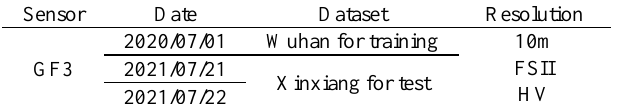
Table 1, the dataset specifications (i.e. imaging date, product type, and sensor mode, resolution and area) are provided.